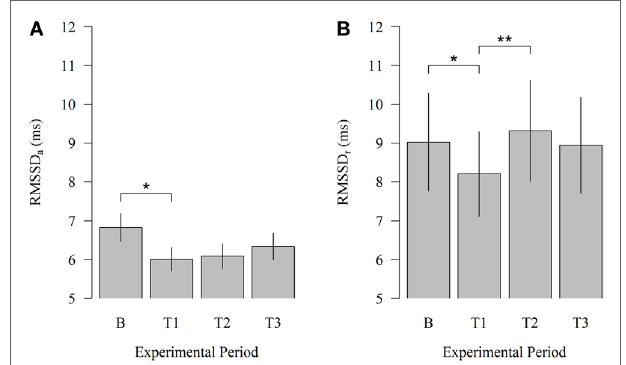
FigUre 2 | effects of the robot scraper on the heart rate variability of dairy cows . (a) Root mean square of successive beat-to-beat differences (RMSSD) during physical activity and (B) at rest in the baseline measurement (B) and test measurements (T1, T2, T3). Vertical lines indicate SEMs and asterisks significant differences between means of the different experimental periods (* P < 0.05, ** P < 0.01, *** P < 0.001). RMSSD a , RMSSD of cows during physical activity. RMSSD r , RMSSD of cows at